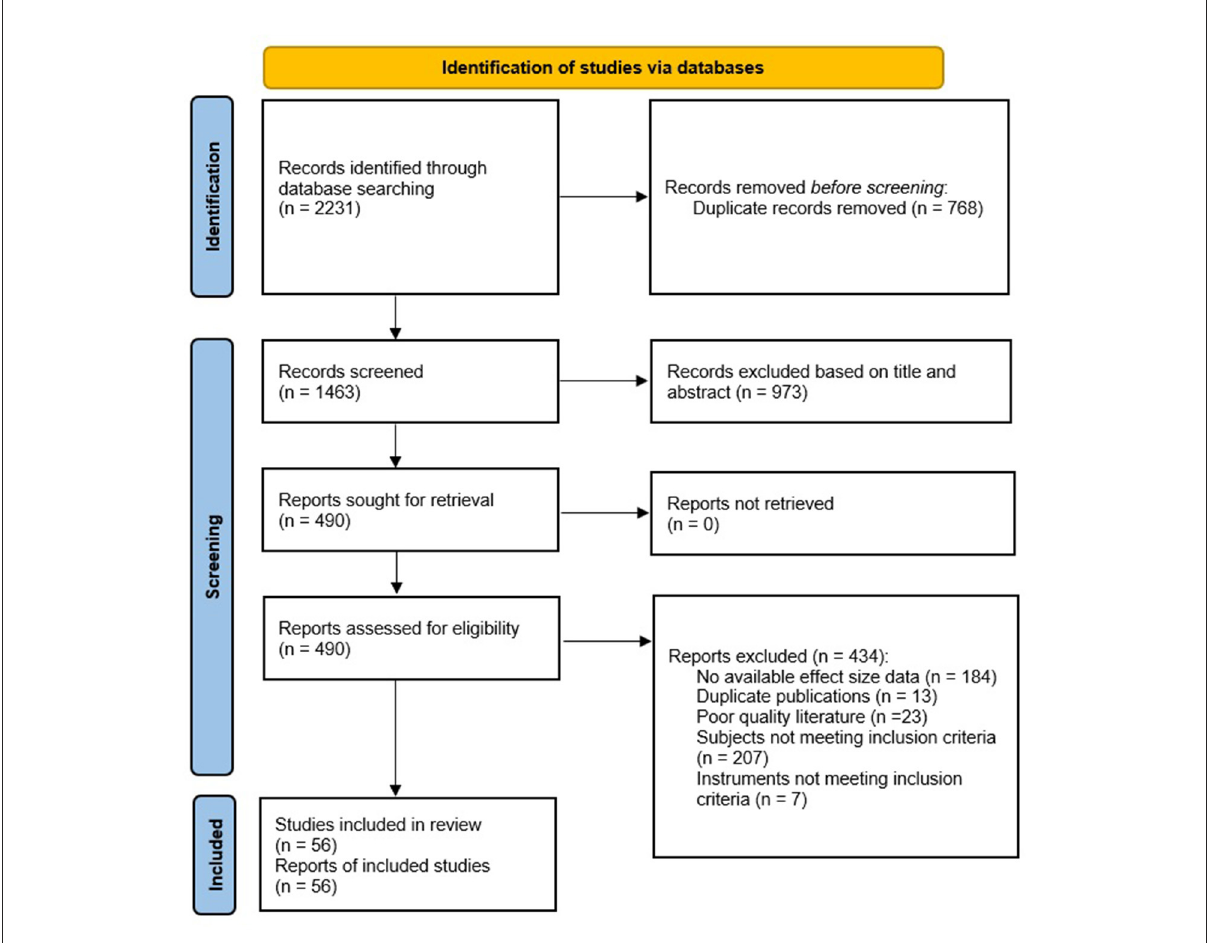
FIGURE1 The flow chart of the study selection process.